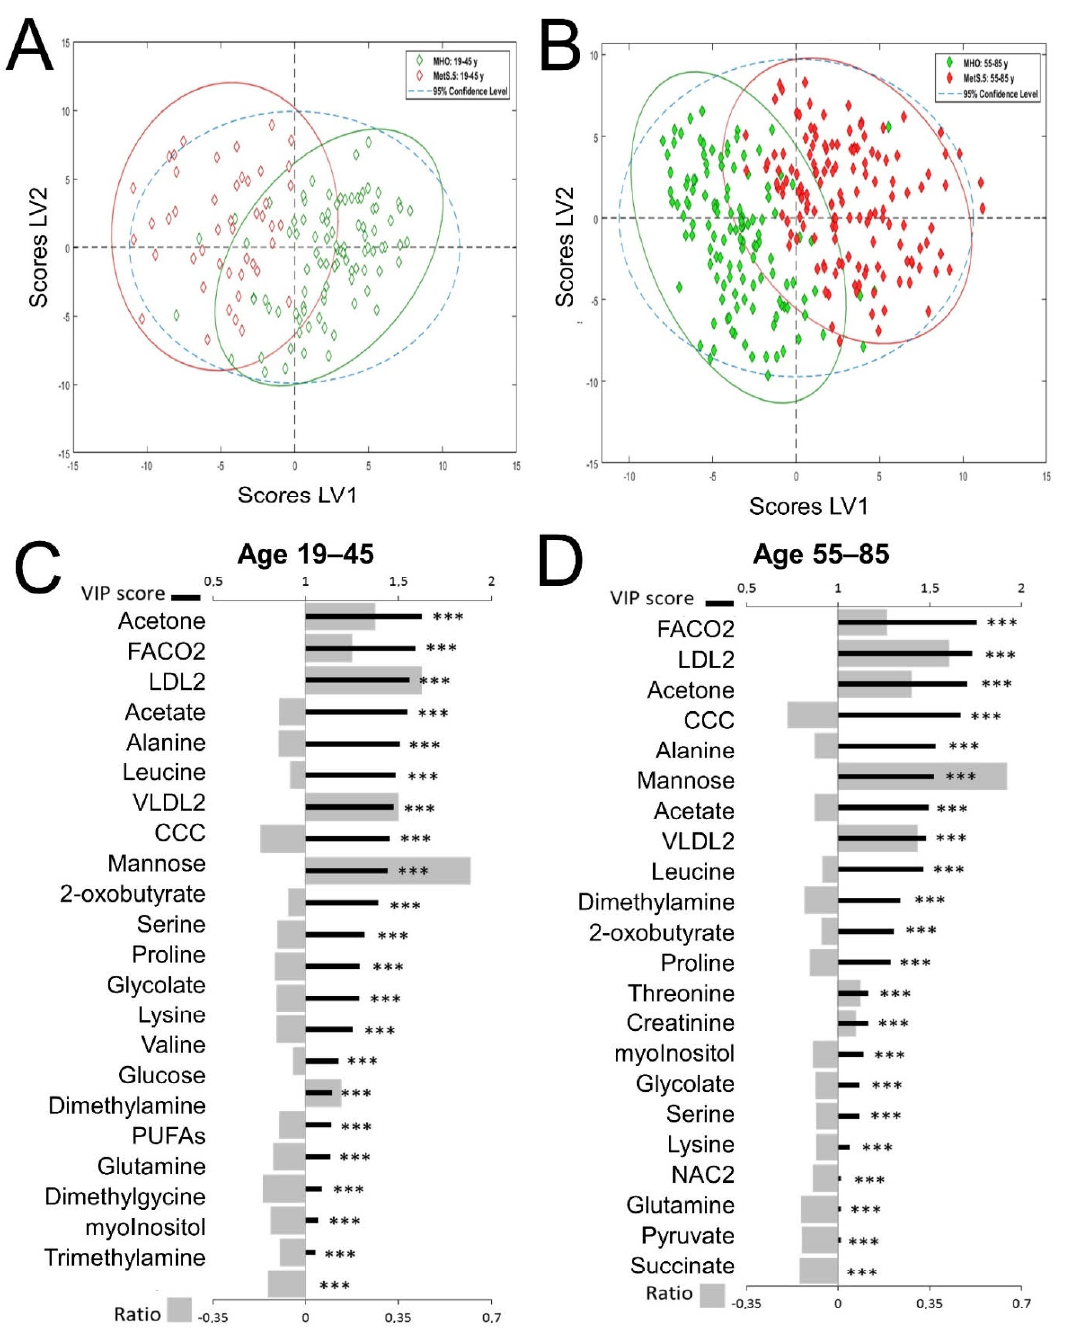
Figure 2. PLS-DA model for discrimination between MetS.5 and MHO by age range. All models were built using 2 latent variables (LV). All scores plots show MetS.5 samples in red and MHO samples in green with 95% confidence ellipse in the same colors. VIPs scores are represented as thick black lines (scale on the top) and relative fold change calculated as (Metabolite mean concentration of Mets.5—Metabolite mean concentration of MHO)/Metabolite mean concentration of MHO, are represented by grey bars (scale on the bottom). Significant alterations are indicated by *. Adjusted p -values (Student’s t -test corrected by Bonferroni method) to 0.000018 (***). ( A ). Scores plot for the age range 19 to 45 years model. Cross-validation parameters: RMSECV 0.304, R2CV: 0.582; ROC Curve AUC: 0.96. ( B ). Scores plot for the age range 55 to 85 years model. Cross-validation parameters: RMSECV 0.300, R2CV: 0.640; ROC Curve AUC: 0.97. ( C ). VIP score and relative fold change bar plot for the age range 19 to 45 years model. ( D ). VIP score and relative fold change bar plot for the age range 55 to 85 years